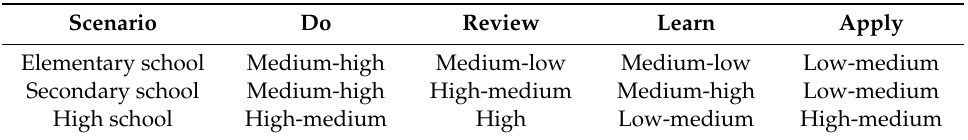
Table 3. Success